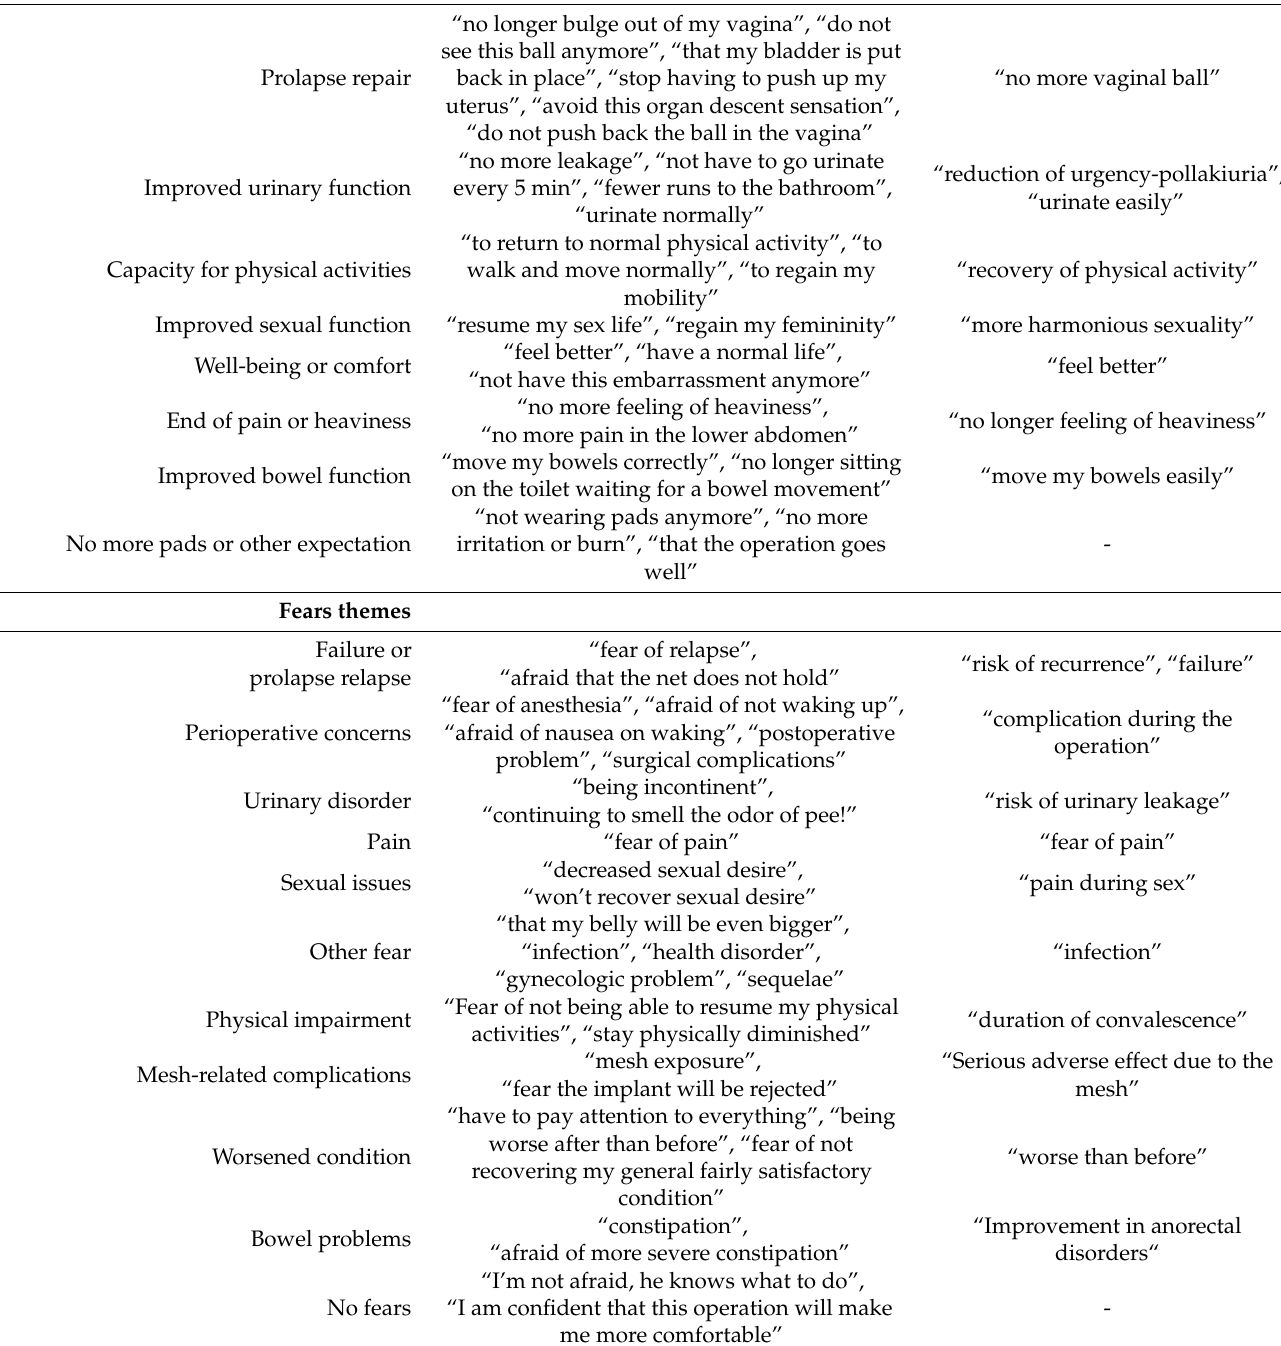
Table 2. Hope and Fears thematic classification for women and surgeons (examples of